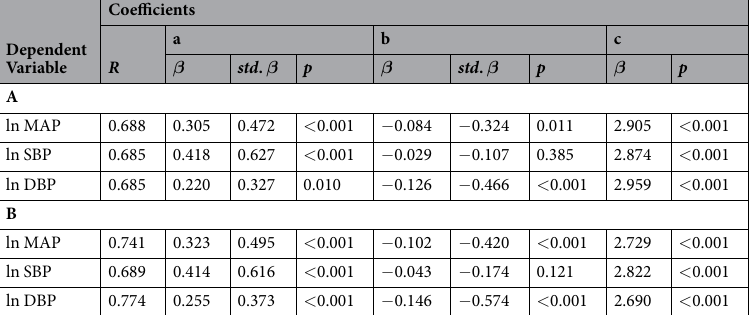
Table 2. Multiple linear regression analyses of ln (blood pressure) = a × ln (heart rate) + b × ln (modified normalized pulse volume) + constant (c) using data from ( A ) the smartphone ( N = 49) and ( B ) the dedicated photoplethysmograph ( N = 51). Note . MAP = mean arterial pressure, SBP = systolic blood pressure, DBP = diastolic blood pressure, R = multiple correlation coefficient, β = β coefficient of multiple linear regression, std. β = standardized β